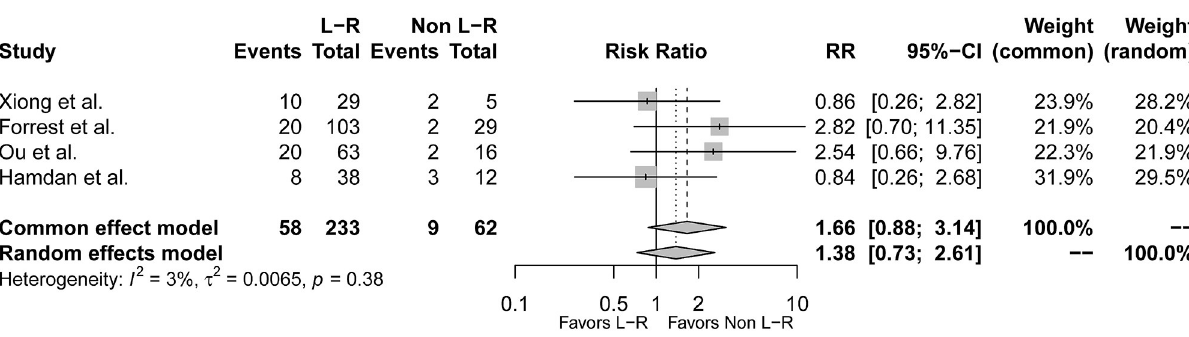
FIGURE 5 | The forest plot of the pooled-analysis comparing post-TAVR conduction abnormalities between type 1 BAV morphology L-R and non-L-R subtype. RR, risk ratio; CI, confidence